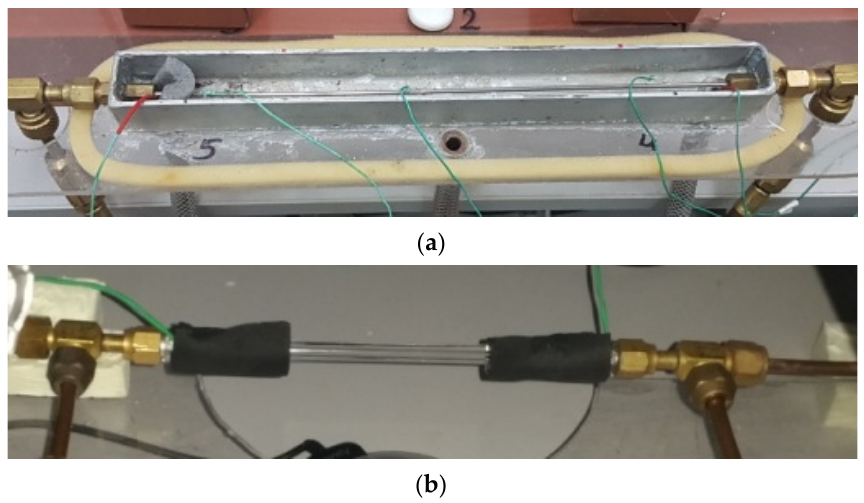
Figure 3. Overall view of the measuring sections: ( a ) for thermal investigations, ( b ) for visualisa-